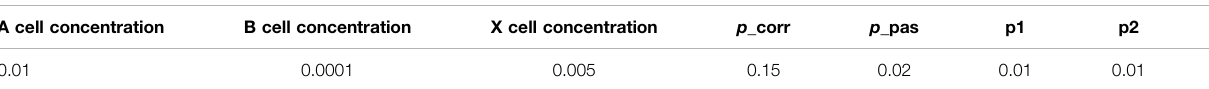
TABLE 4 | Parameter table of cellular automata.